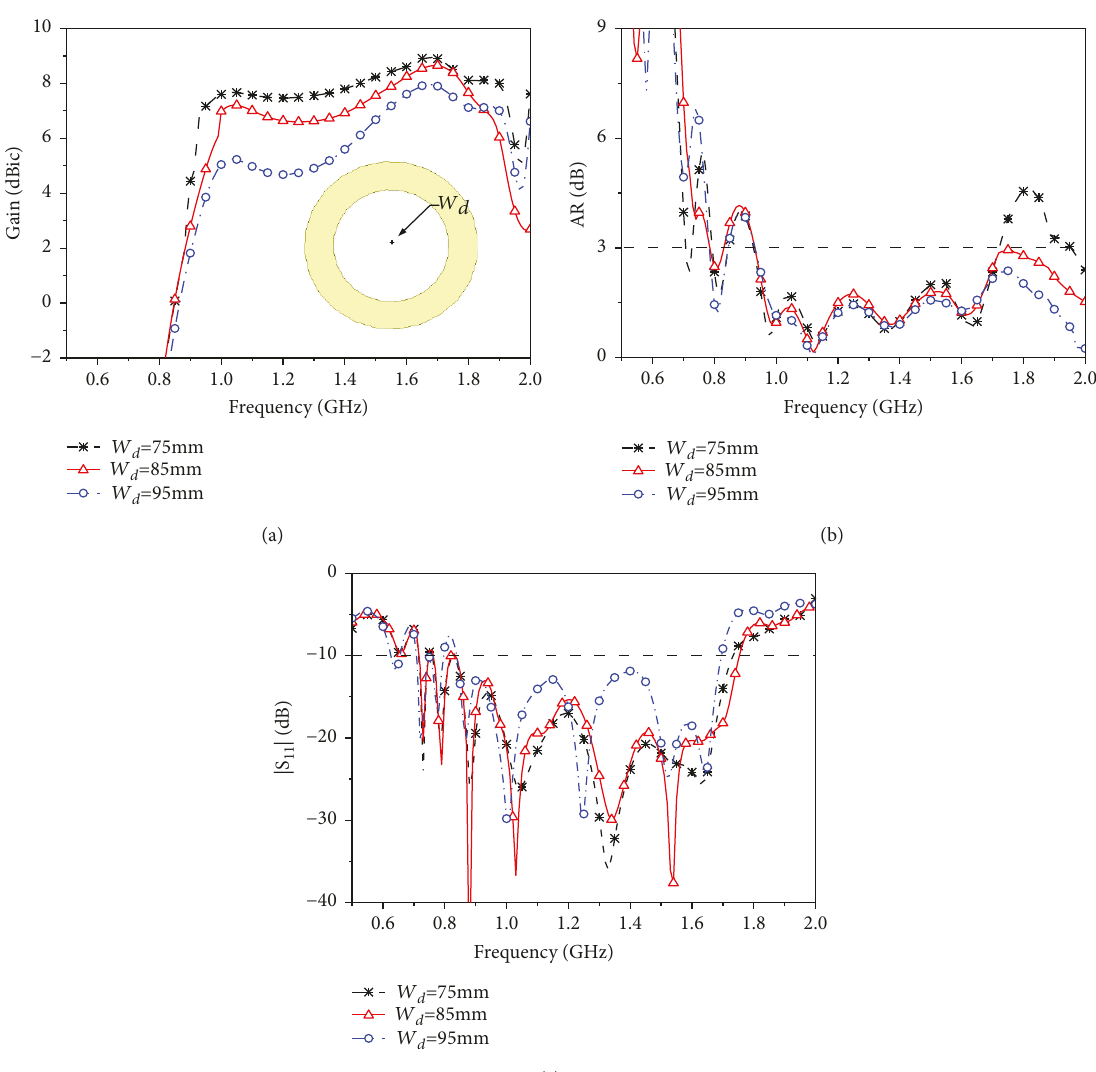
Figure 7: E ff ect of W d on the antenna. (a) Gains and (b) ARs at broadside direction. (c) S 11 s